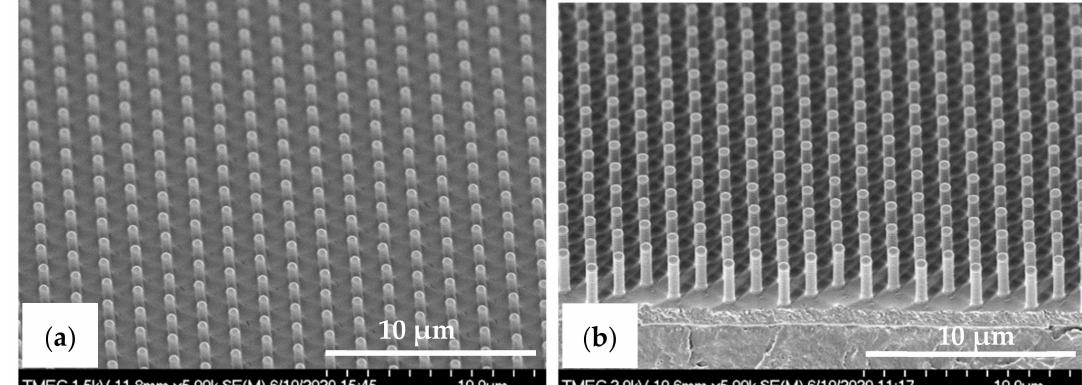
Figure 11. Tilted-view SEM images of the pillar micro-structure (designed pattern size: diameter: 0.5 µ m, height: 2.5 µ m) replicated by R2P NIL process ( a ) imprint on PC foil with resin A (PIL-A) and ( b ) imprint on PC foil with resin B (PIL-B).